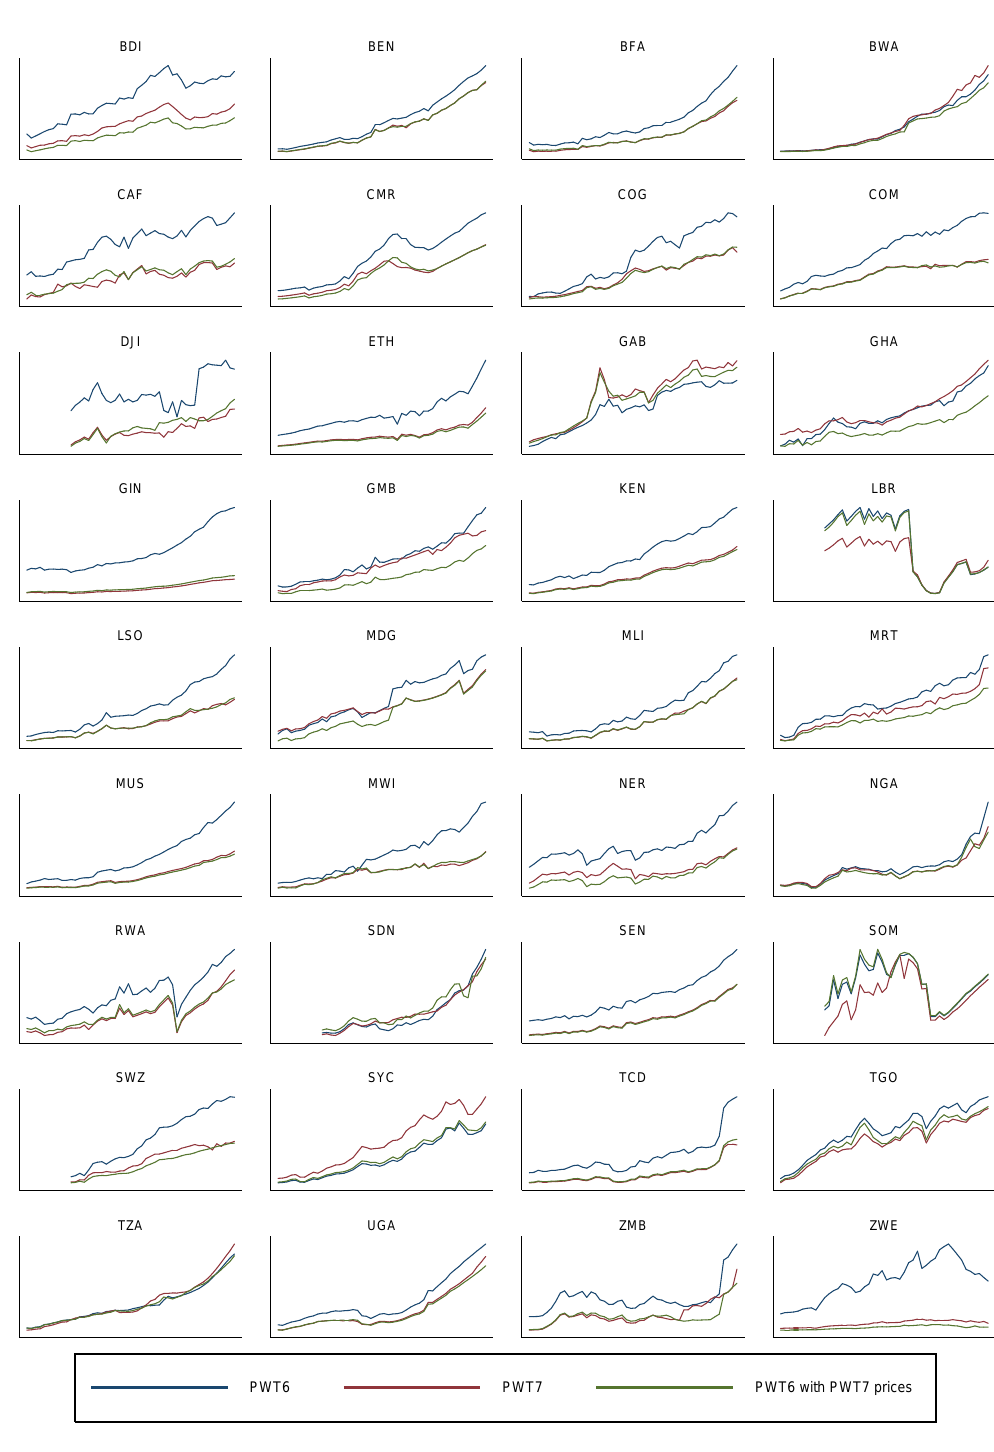
Figure 5: GDP for 36 countries,